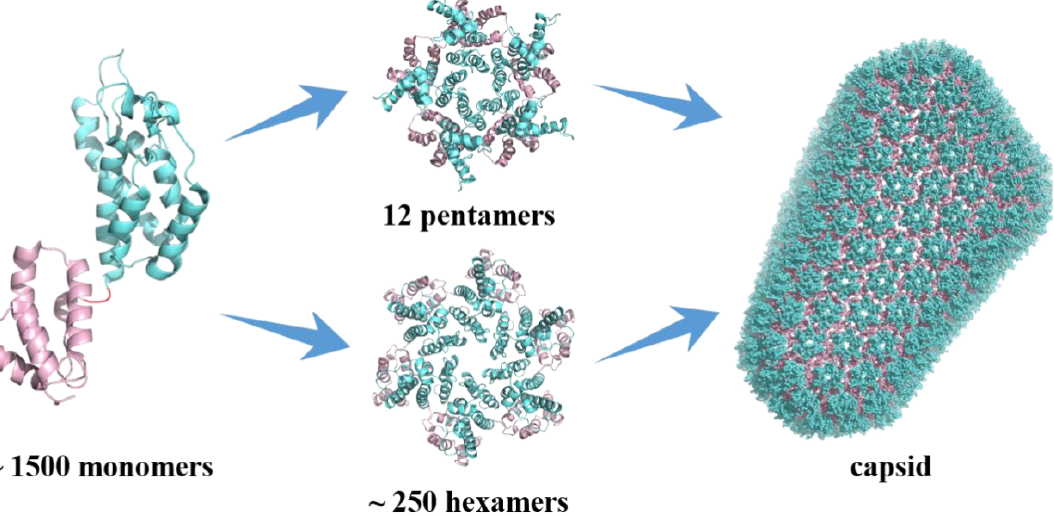
Figure 1. Monomeric and assembled structure of the HIV-1 capsid protein.